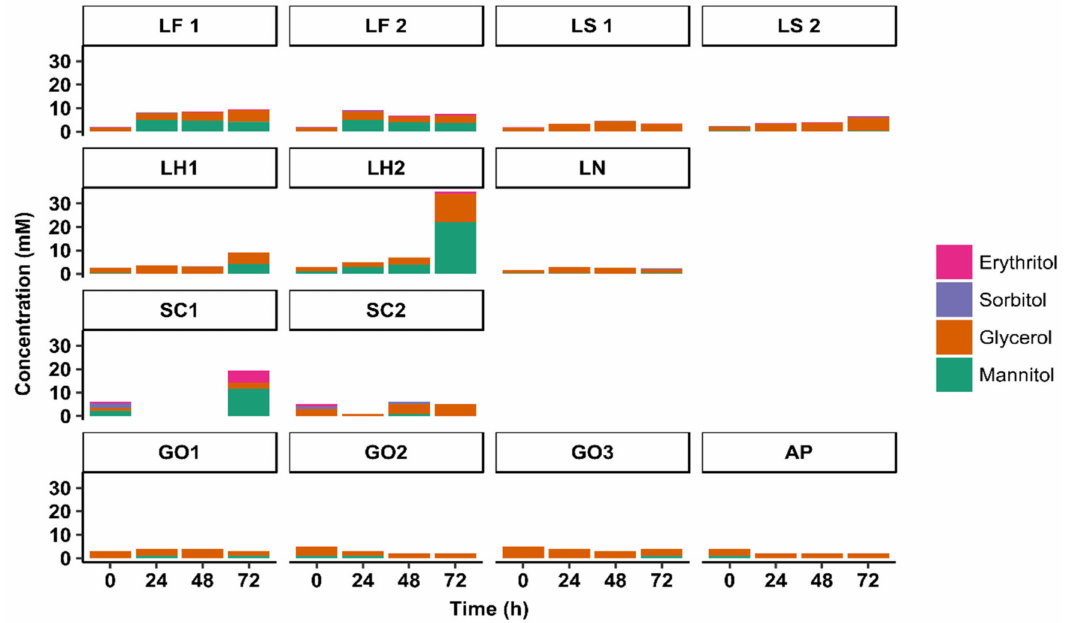
Figure 6. Concentrations of sugar alcohols during starter culture-initiated sourdough productions. The indication of the starter culture strains is as in Table